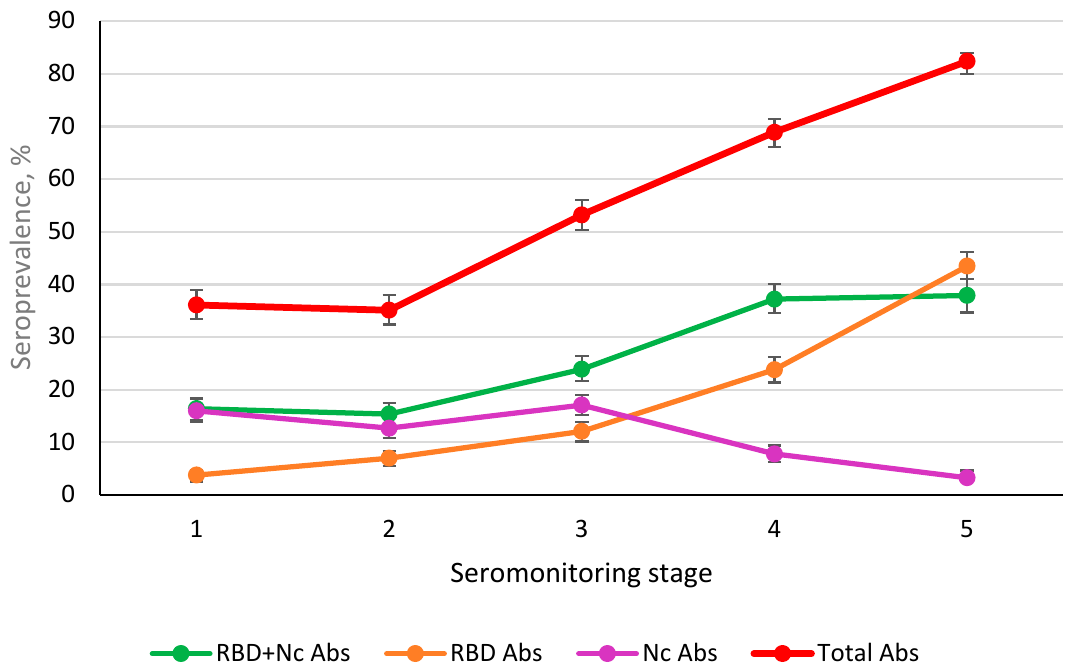
Figure 6. Seroprevalence of anti-Nc and anti-RBD IgG in volunteer plasma, by seromonitoring stage. Key: RBD + Nc double-positive volunteers with both Abs; RBD Abs—volunteers with only RBD Abs; Nc Abs—volunteers with only Nc Abs; Total Abs—total number of seropositive volunteers (RBD + Nc Abs, RBD Abs, Nc Abs) relative to all examined; vertical black lines—95% CI.